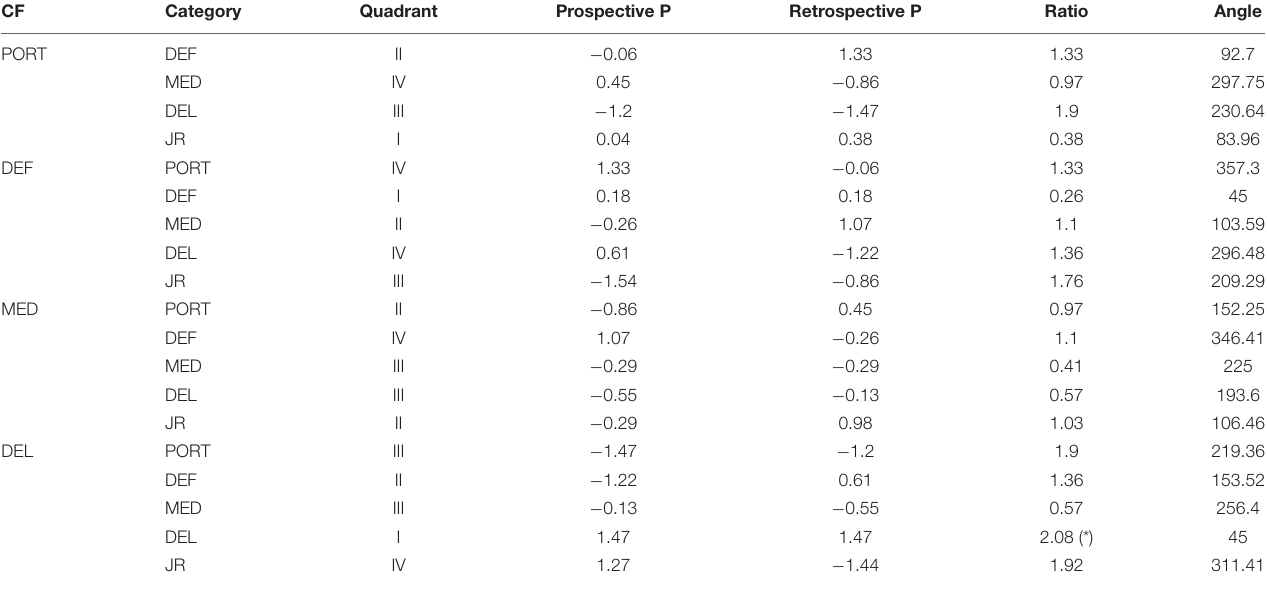
TABLE 13 | Results of the analysis of polar coordinates for the different focal categories in relation to the rest of the lines that make up the game structure of the 2017–2018 season. CF Category Quadrant Prospective P Retrospective P Angle PORT